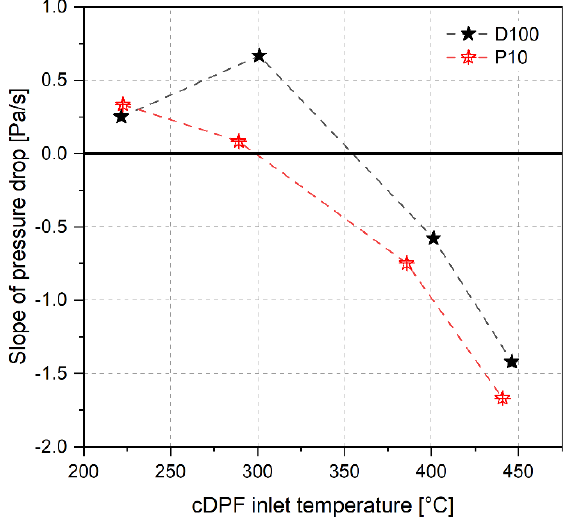
Figure 6. The slope of the pressure drop versus temperature.